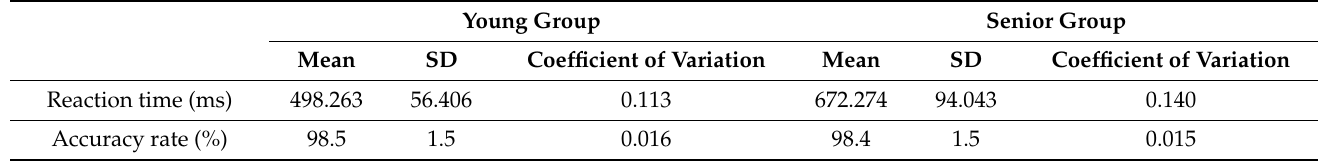
Table 1. Results of reaction time and accuracy rate on flanker tasks for all participants.